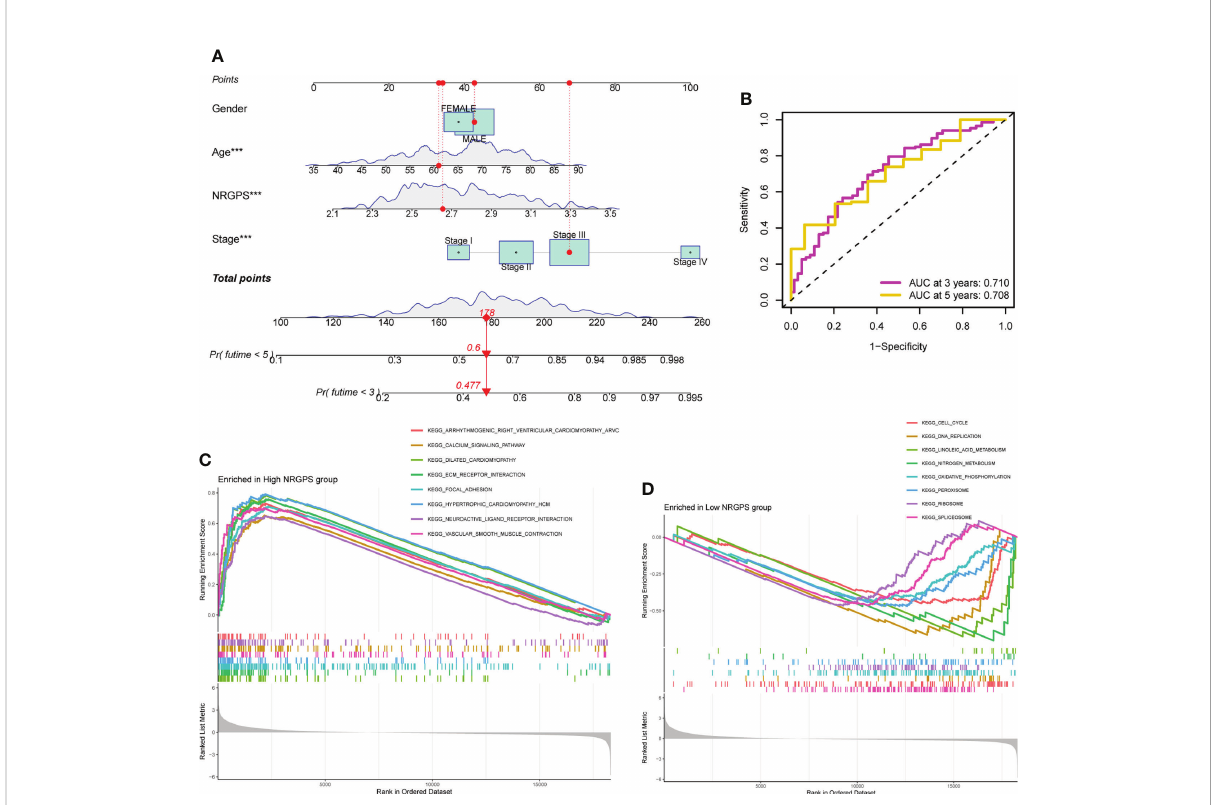
FIGURE 7 Nomograph Model and GSEA Analysis. (A) Nomogram of NRGPS and clinical factors predicting survival probability of GC patients. (B) The ROC curve veri fi es the predictive ability of the nomogram. (C) Enrichment pathways in high-NRGPS group. (D) Enrichment pathways in low-NRGPS group. GSEA, Gene Set Enrichment Analysis; NRGPS, necroptosis-related gene prognostic score; GC, Gastric cancer; ROC, receiver operating characteristic. *** p <